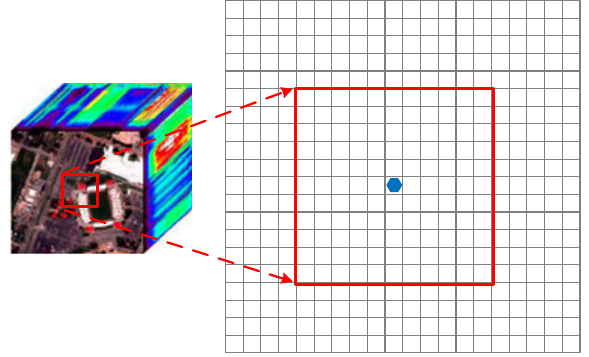
Figure 7. Schematic diagram of selecting the neighborhood pixels.